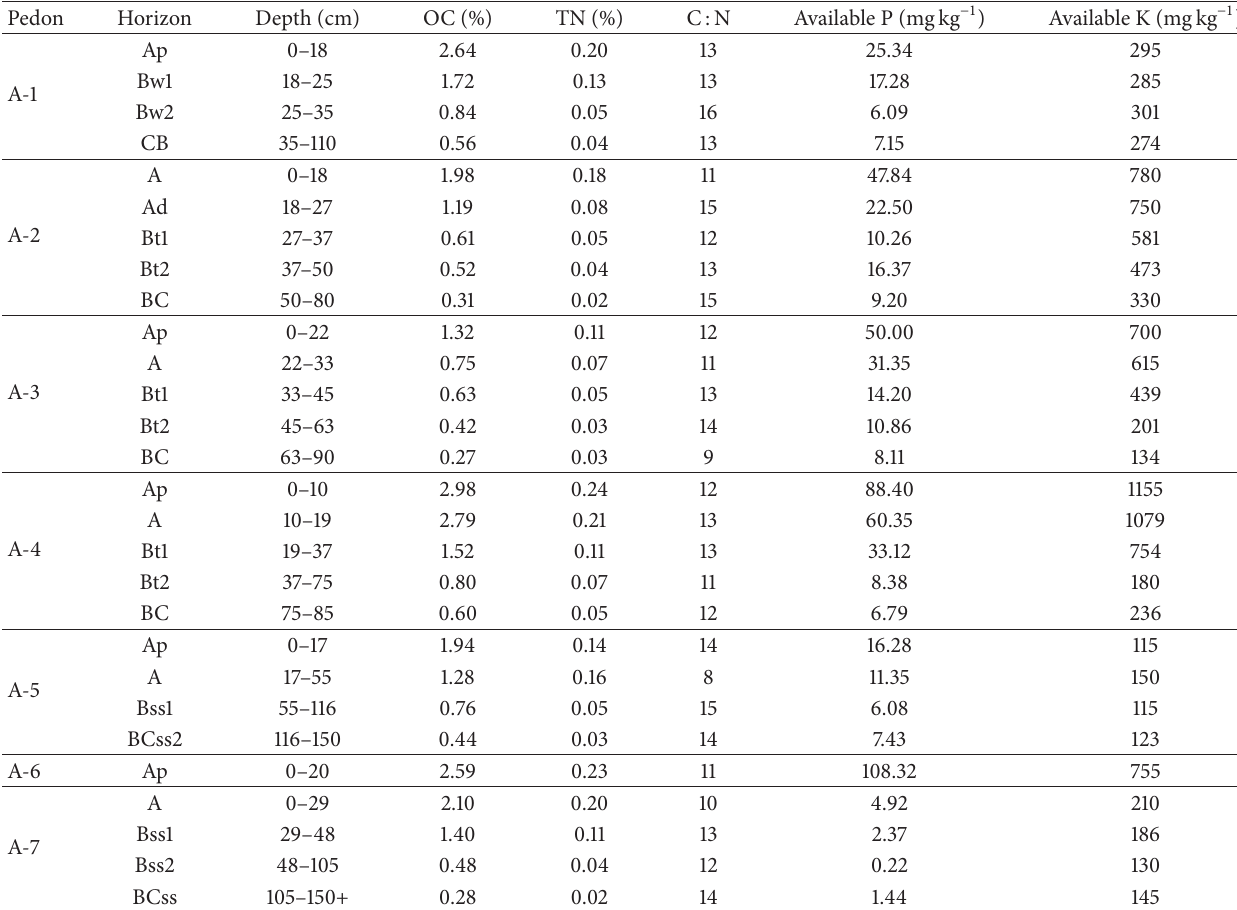
Table 7: Organic carbon, total nitrogen, carbon to nitrogen ratio, available P, and available K contents of soils of Abobo area.